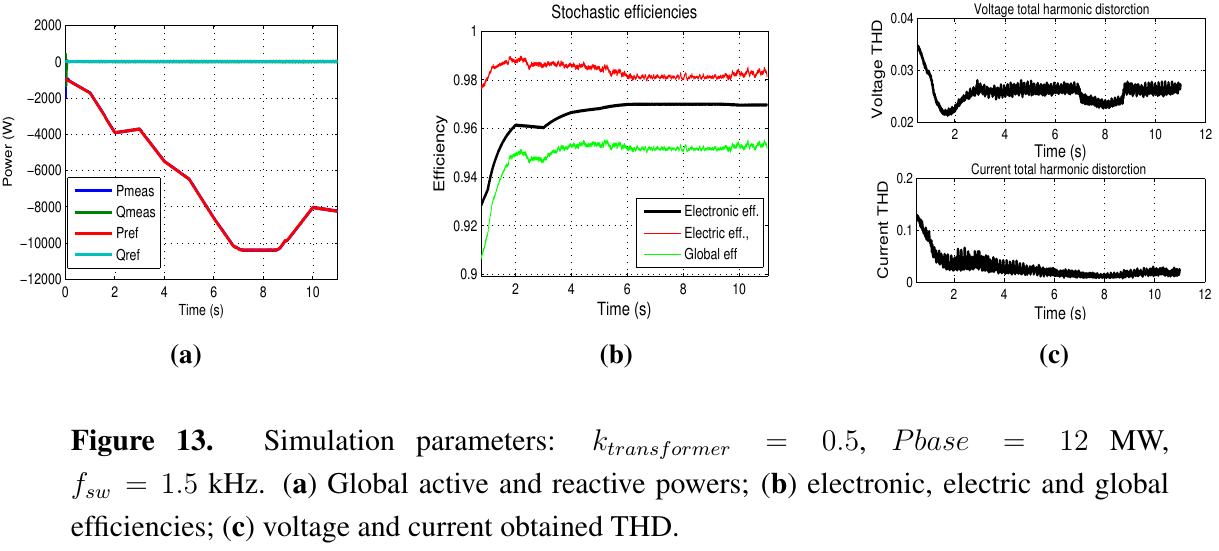
Figure 13. Simulation parameters: k f = 1 . 5 kHz. ( a ) Global active and reactive powers; ( b ) electronic, electric and global sw efficiencies; ( c ) voltage and current obtained